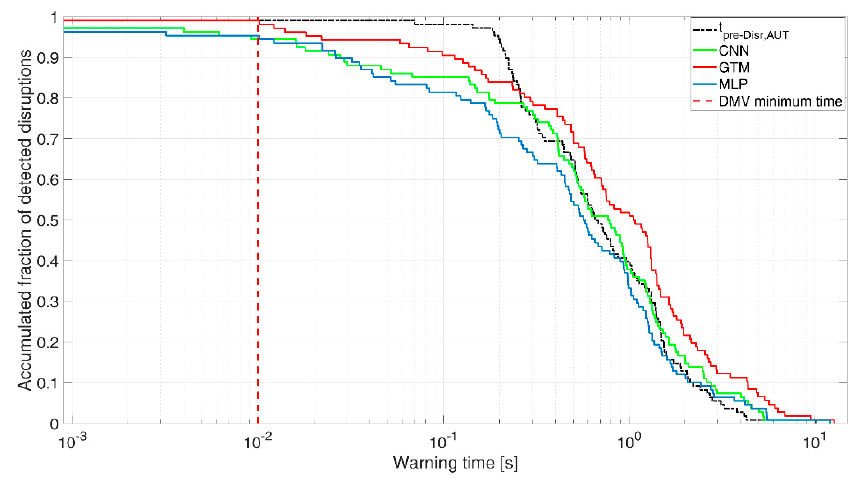
Figure 9. Accumulated fraction of detected disruptions by the MLP-NN (blue line), the GTM (red line), and the CNN (green line) models versus the warning time in the test set. The vertical red dashed line allows us to identify tardy detections. The dashed black curve refers to the t pre − disr − AUT .